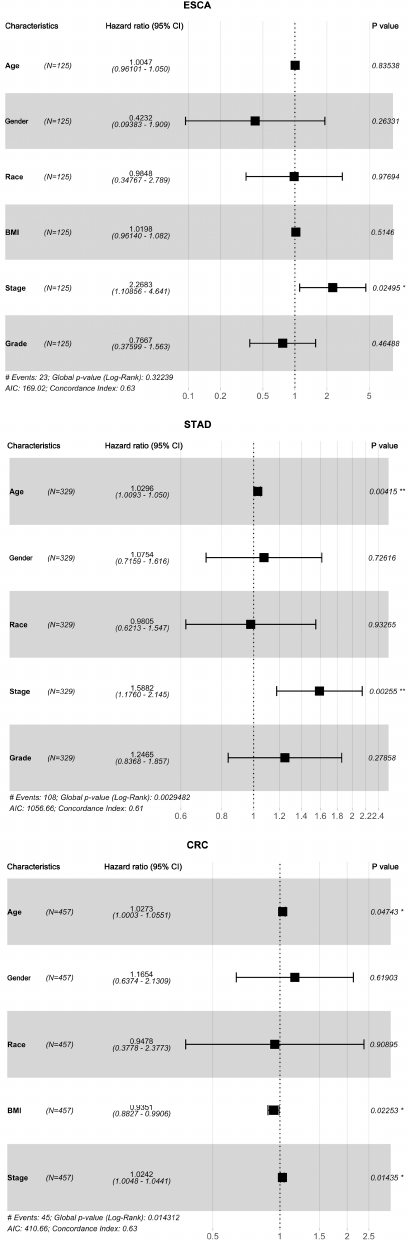
Figure 5. Forest plots of univariate Cox regression analysis in ESCA, STAD, and CRC tumours based on the corresponding clinical parameters. BMI: Body mass index. * p < 0.05, ** p < 0.01.